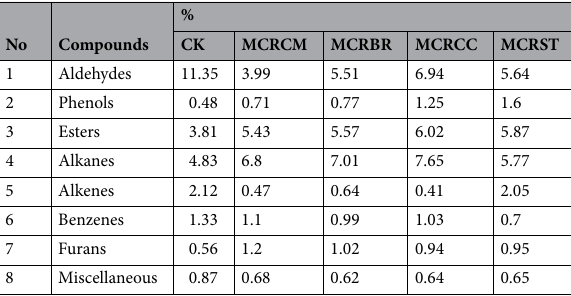
Table 3. Effects of mixed ensilage on the contents of VOCs in